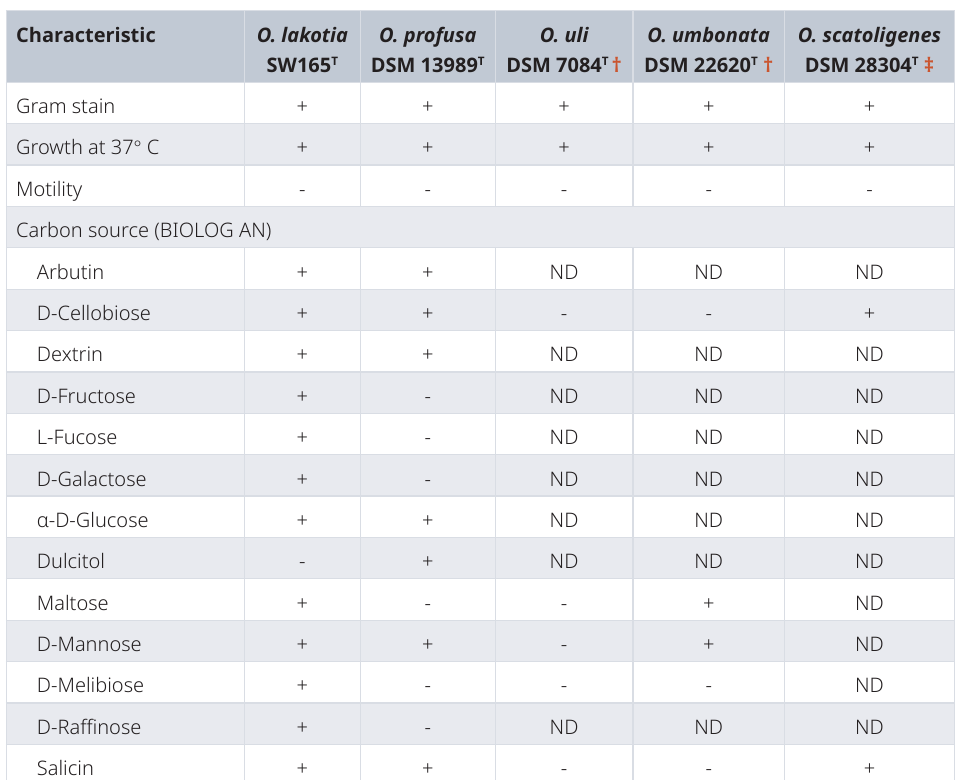
Table 1. Phenotypic characteristics of O. lakotia SW165 T and closely related strains. Column headers show Strains designated: SW165 T ; O. profusa DSM 13989 T ; O. uli DSM 7084 T ; O. umbonata